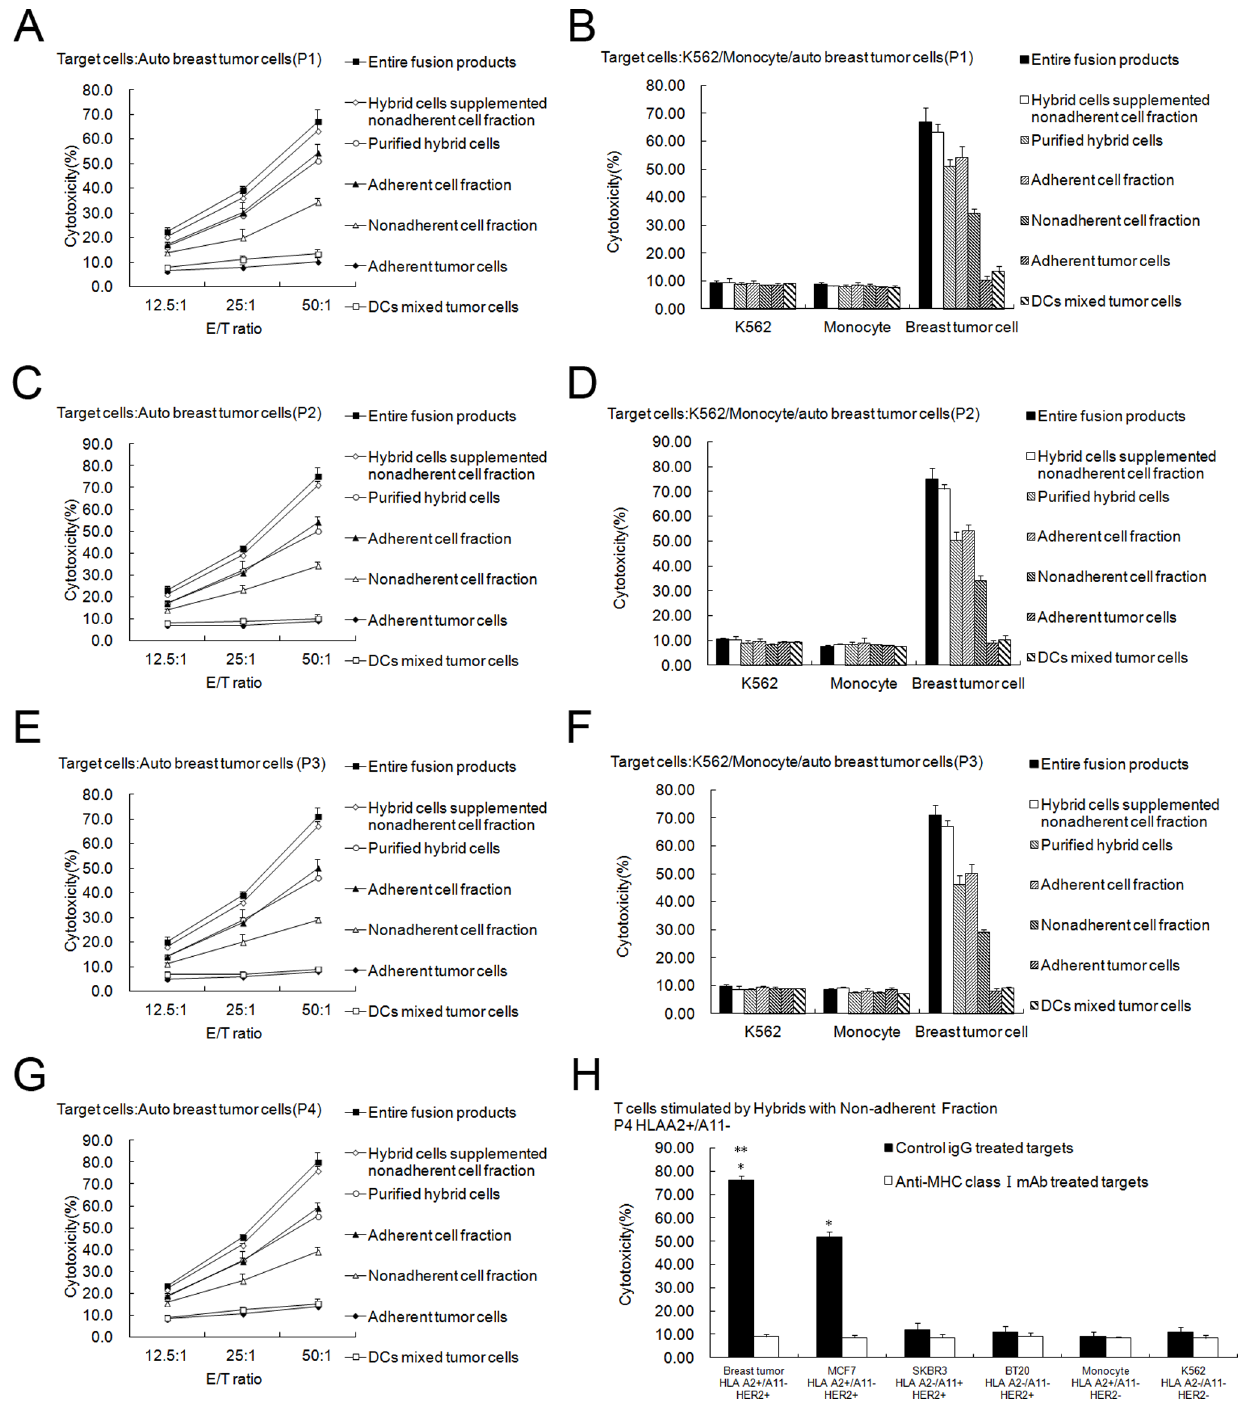
Figure 4. CTL assays induced by purified DC-tumor hybrids or other components of the fusion products. The cytotoxicity assays were performed using CytoTox 96 Non-Radioactive Cytotoxicity Assay kit. (A, C, E, G) Non-adherent PBMCs stimulated with total fusion products ( & ), hybrid cells supplemented with the non-adherent cell fraction ( e ), purified hybrid cells ( # ), the adherent cell fraction ( m ), the non-adherent cell fraction ( g ), adherent tumor cells ( ¤ ), or DCs mixed with tumor cells ( % ) for 7 days in the presence of 20 units/mL human IL-2 were used as the effector T cells. Then breast tumor cells were co-cultured with the effector T cells for 4 h at ratios of 1:12.5, 1:25, and 1:50, respectively. Points , mean values of triplicate samples; bars , SD. The results showed that T lymphocytes activated by purified hybrids, the adherent cell fraction, the non- adherent cell fraction, total fusion products, purified hybrid cells supplemented with the non-adherent cell fraction lysed auto breast tumor cells much more effectively than T cells activated by adherent tumor cells or DC mixed with tumor cells ( P , 0.05). Lysis induced by total fusion products or purified hybrid cells supplemented with the non-adherent cell fraction was the most effective. Purified hybrid cells or the adherent cell fraction induced more effective lysis than the non-adherent cell fraction ( P , 0.05). There was no difference between total fusion products and purified hybrid cells supplemented with the non-adherent cell fraction or between purified hybrids and the adherent cell fraction ( P . 0.05). (B, D, F) Natural killer-